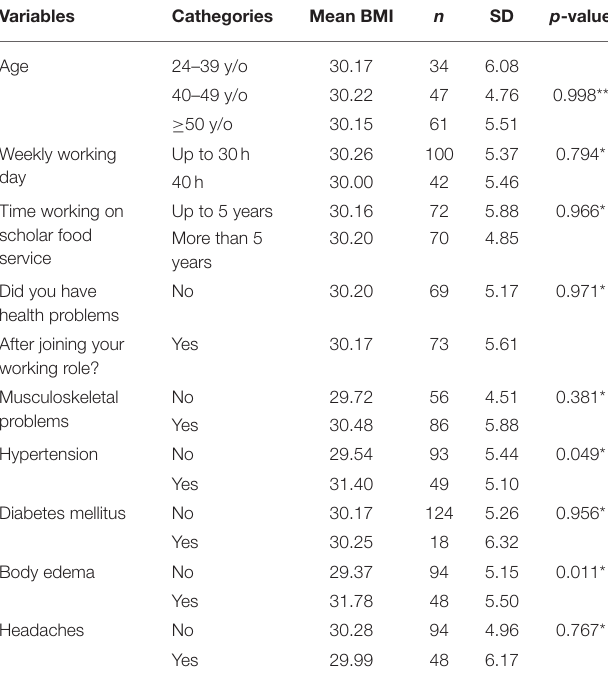
TABLE 5 | Mean and standard deviation (SD) of body mass index (BMI) and association of sociodemographic and occupational characteristics and comorbidities of food handlers.